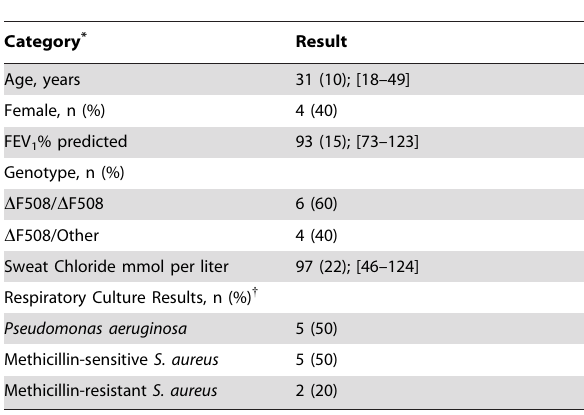
Figure 3. In contrast to the healthy volunteers (HV, bottom row of Fig. 3), CF patients exhibit visible spatial heterogeneity in the nT1 maps. Specifically, all CF patients (including the other 5 CF patients not shown in Fig 3) exhibited regions of decreased nT1 values, particularly in the upper lung regions (black arrows in Fig. 3 right column). Importantly, these observed lung ‘‘lesions’’ are